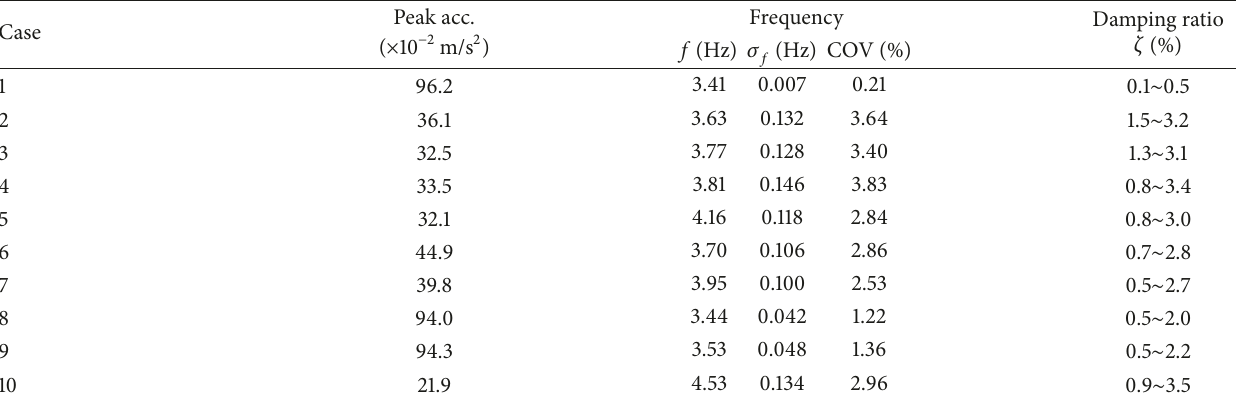
Table 4: Natural frequencies and damping ratios estimated from free vibration